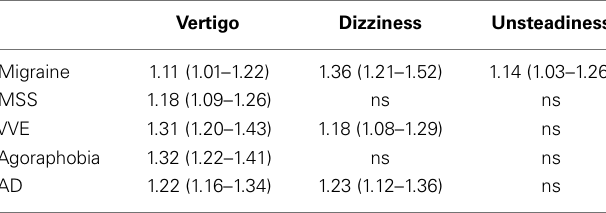
Table 5 | Logistic regression for each co-morbidity controlling for gender, age, and eachVDU